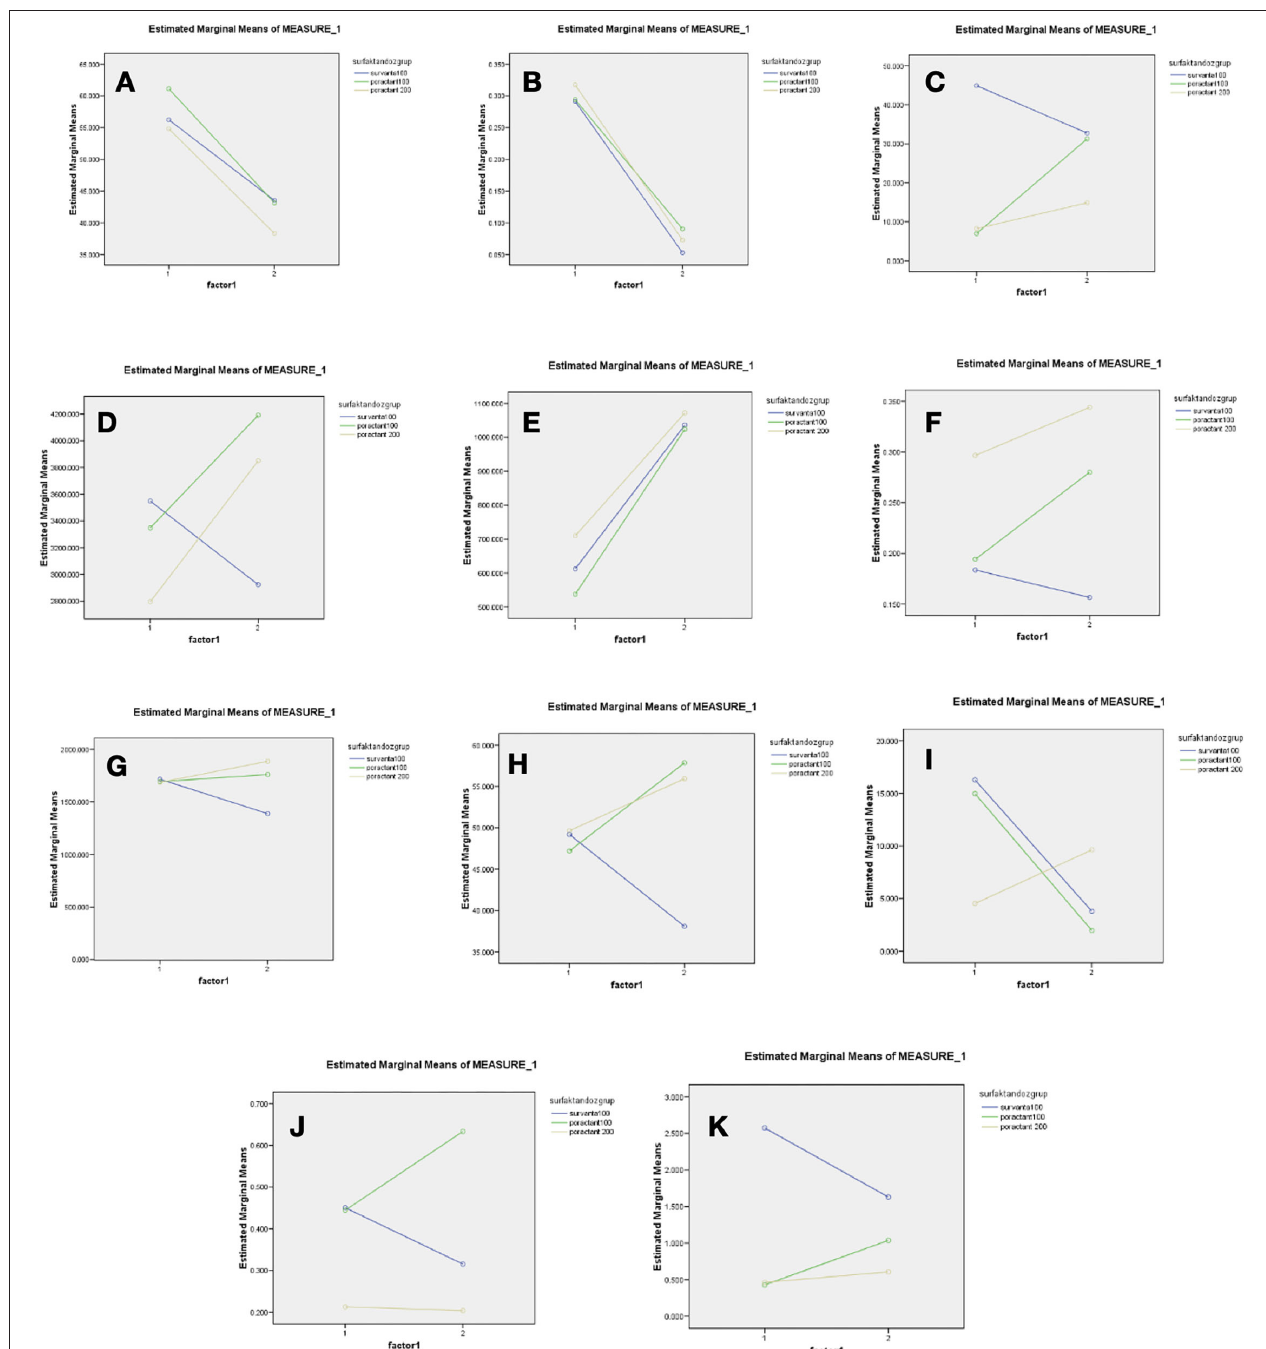
FIGURE 1 | Levels of intratracheal chemokines and cytokines before and after surfactants administration in all three groups (A) TA [Eosinophil (%)] (B) TA (IFN- γ ) (C) TA (8Eotaxin) (D) TA (TGF beta) (E) TA (IL-8) (F) TA (IL-9) (G) TA (ITaC) (H) TA (MIP) (I) TA (IgE) (J) TA (IL-5) (K) TA (IL-10).